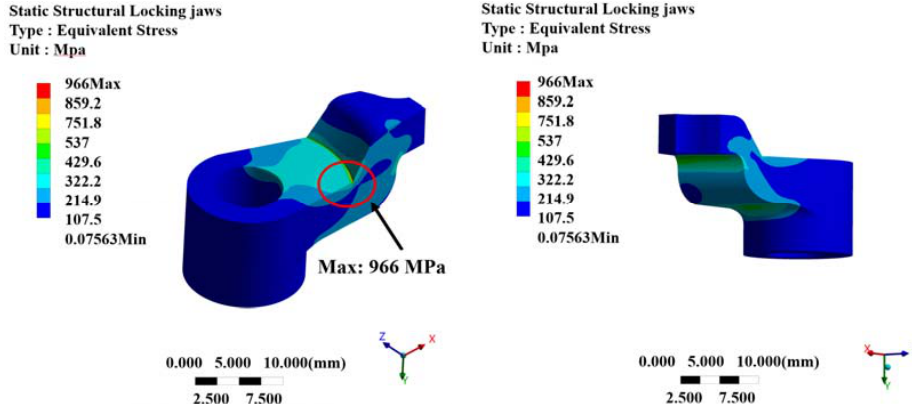
Figure 7. Stress distribution of locking jaws before optimization.